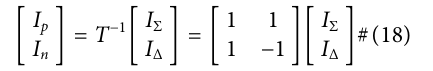
Table 1 provides the corresponding system parameters. The system adopts master-slave control strategy. MMC1 is the master station, and the rest are slave stations.